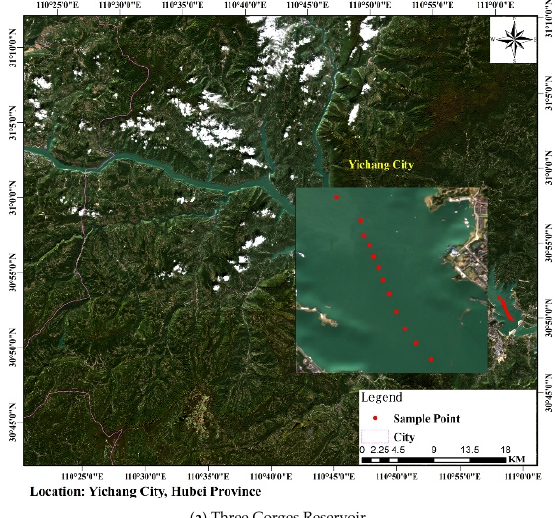
( a ) Three Gorges Reservoir.